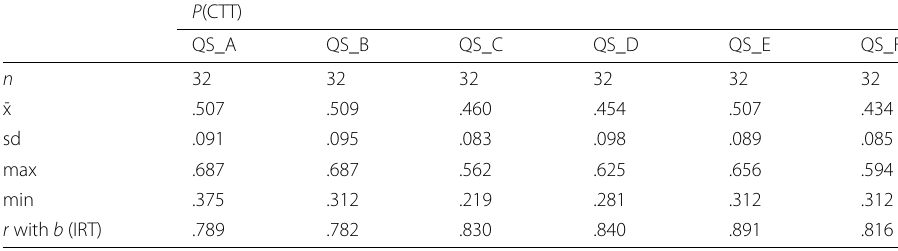
Table 5 Descriptive statistics of the estimated item difficulty